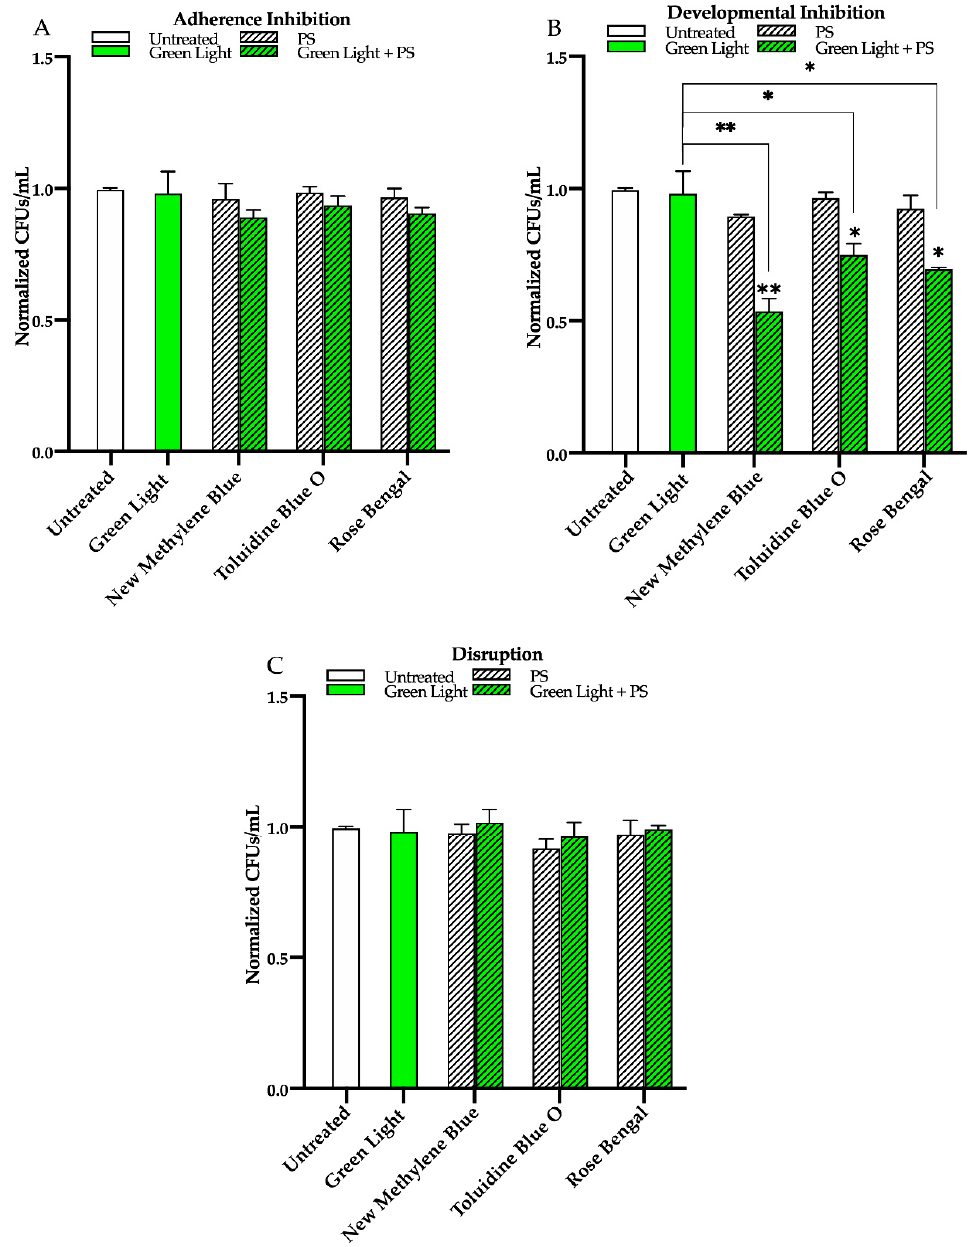
Figure 4. Effects of green visible light in combination with the photosensitizing compounds new methylene blue, toluidine blue O, and rose bengal on C. albicans biofilms. Effects of green light in combination with the photosensitizing compounds in the ( A ) adherence inhibition, ( B ) developmental inhibition, and ( C ) disruption biofilm assays. Untreated control (Untreated), green light alone (Green Light), photosensitizing compound alone (PS), and green light in combination with the photosensitizing compound (Green Light + PS) are shown. Colony forming units per 1 mL (CFUs/mL) were measured to determine viable cell counts from the biofilms at the end of each biofilm assay. Standard deviations are shown for each sample ( n = 3). The average CFUs/mL of the untreated control samples for each assay were normalized to 1. Significance comparisons are relative to the untreated control unless otherwise noted with significance bars and were determined using Student’s unpaired two-tailed t-tests assuming unequal variance for p ≤ 0.05 (*), and p ≤ 0.01 (**).